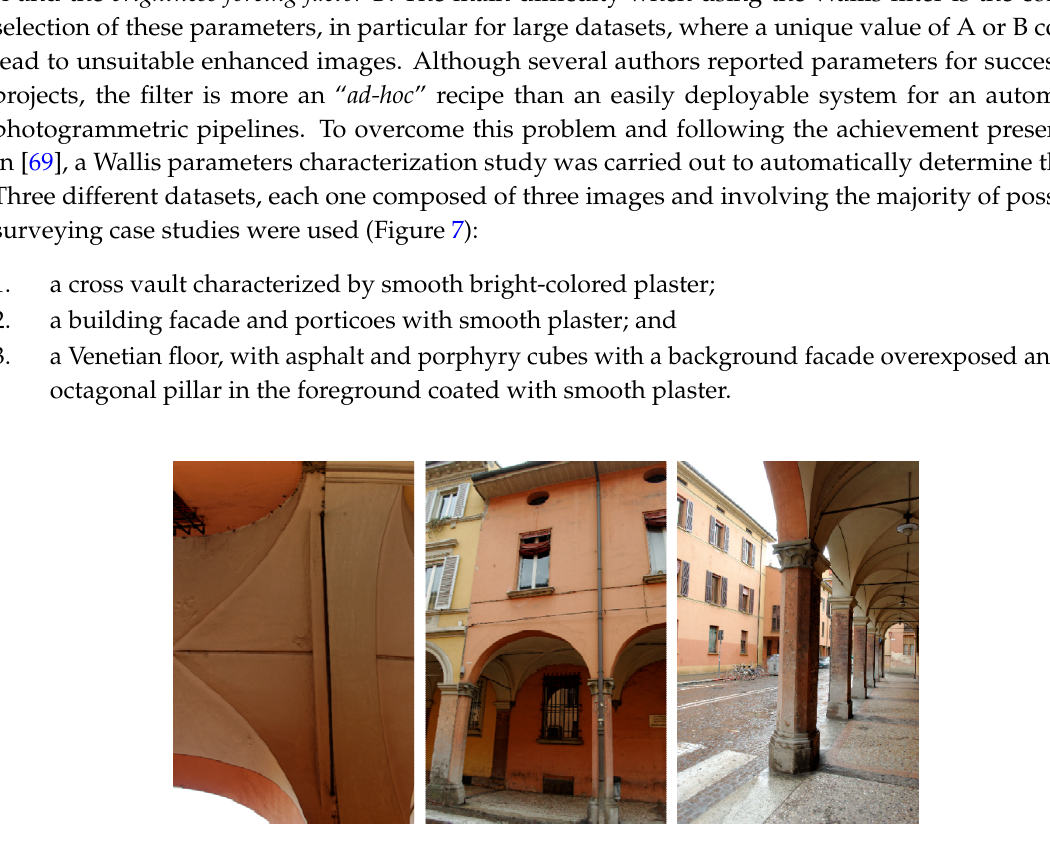
Figure 7. Employed datasets (cross vault with plaster, building façade and Venetian floor, to study the automatic selection of the Wallis filter